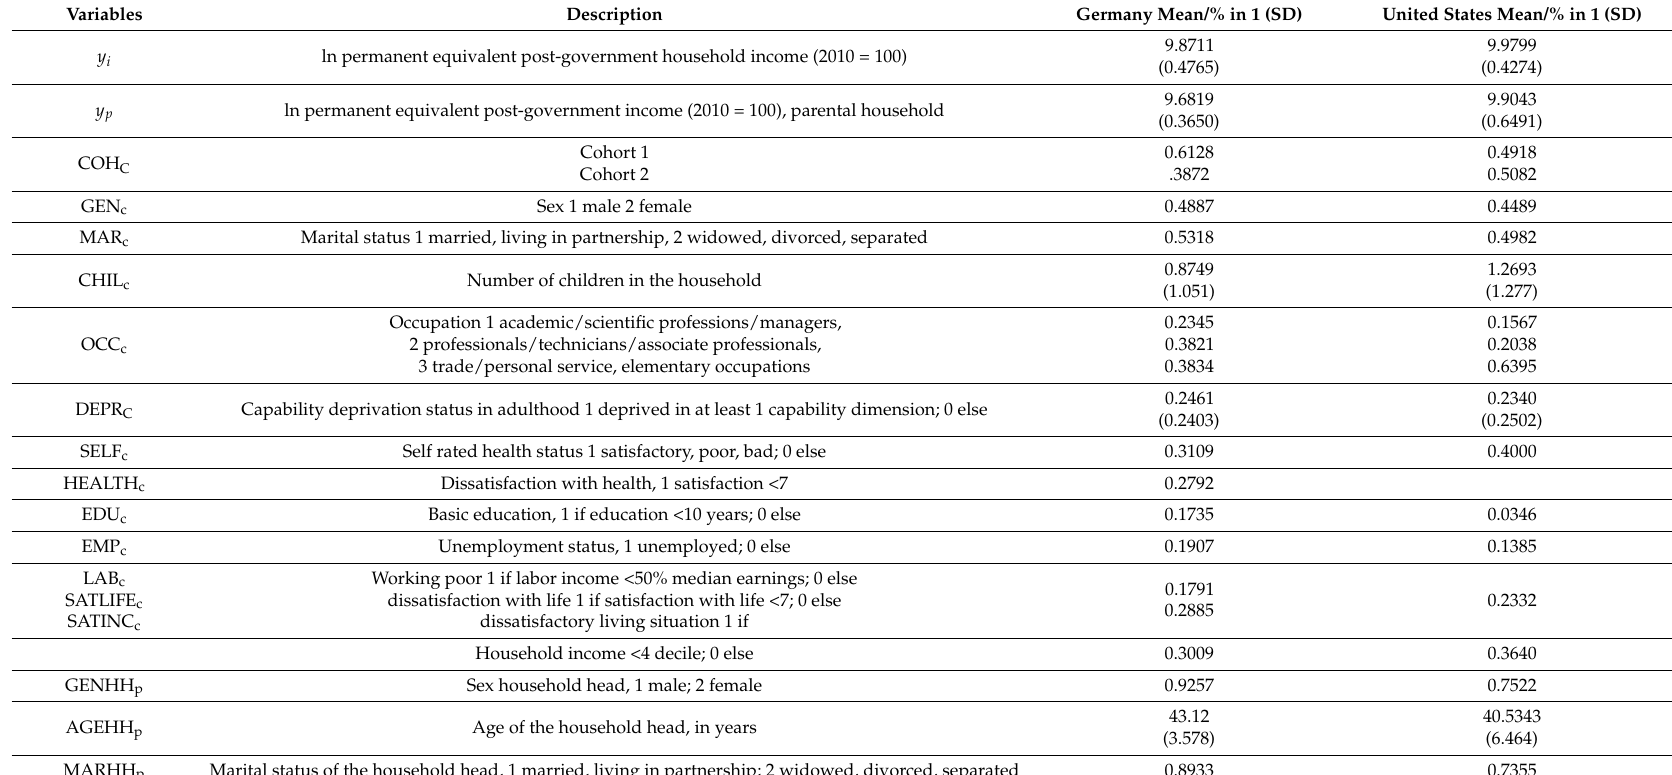
Table 2. Description of the variable, descriptive statistics, pooled